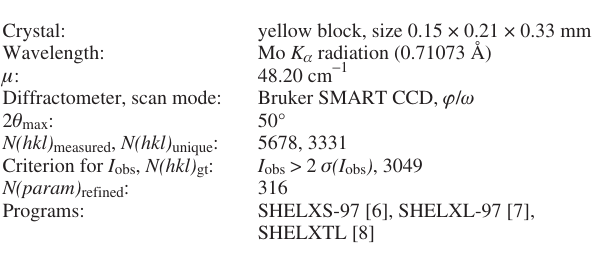
Table 1. Data collection and handling.